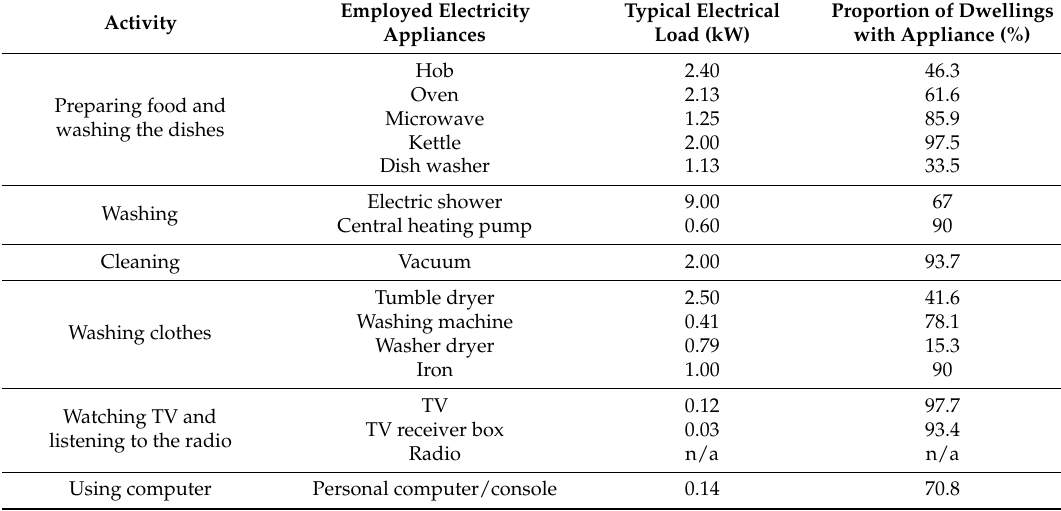
Table 1. Time-use activities and associated appliances, including electrical load and proportion of dwellings with